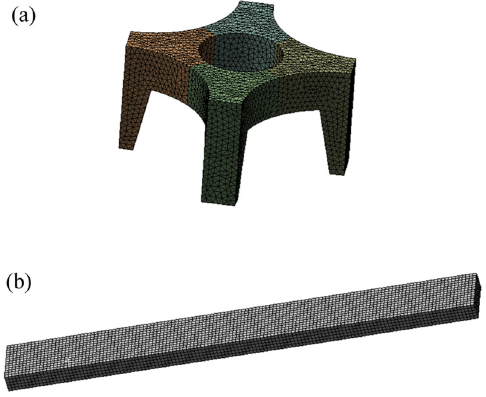
Figure 5: Meshing situation. ( a ) Mesh of armature and ( b ) mesh of